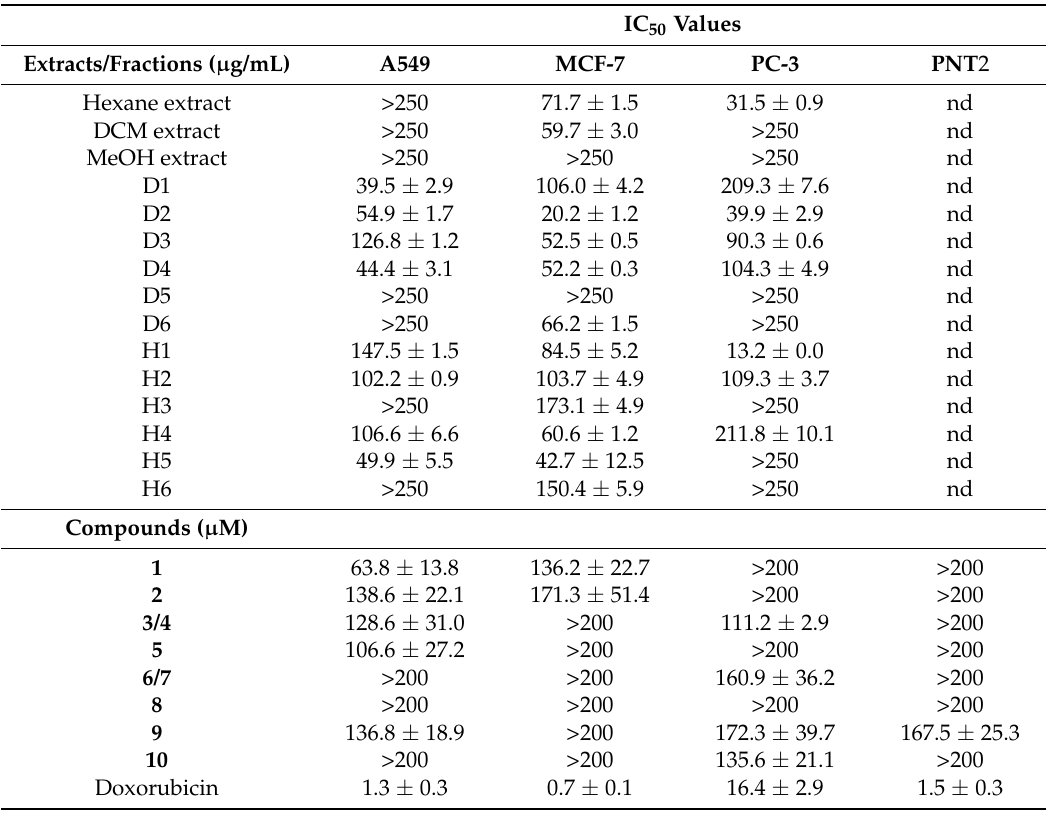
Table 1. Cell growth inhibitory activities of the extracts, fractions and isolated compounds against cancer and noncancerous (PNT2) cells